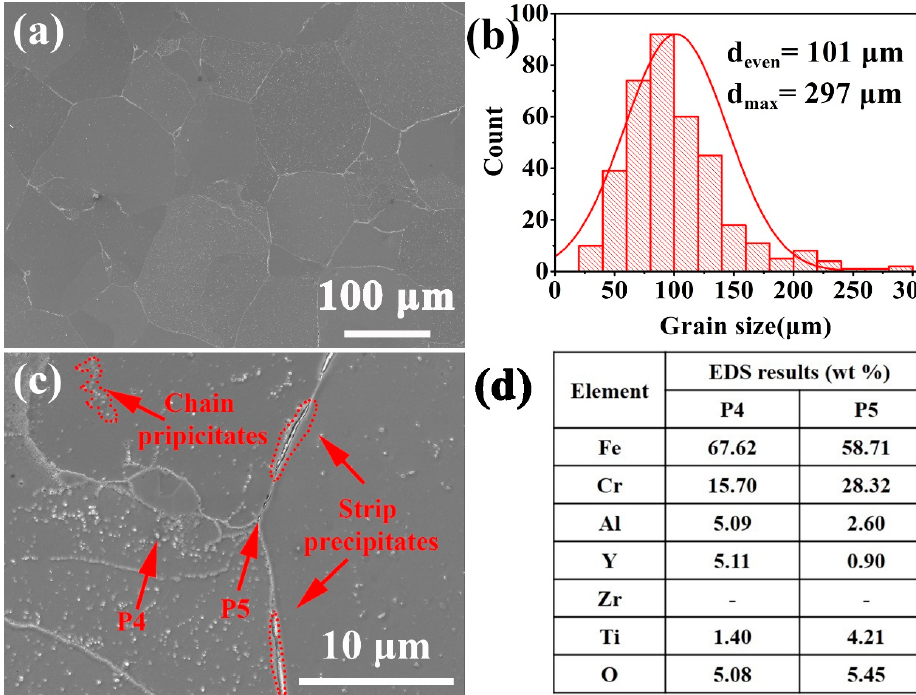
Figure 4. Microstructure of the as-HIPed alloy B: ( a ) SEM secondary electron micrograph of the macrostructure; ( b ) distri- bution of grain sizes for the as-HIPed alloy B; ( c ) SEM secondary electron micrograph of precipitates at grain boundaries and ( d ) EDS results of the precipitates in ( c ).